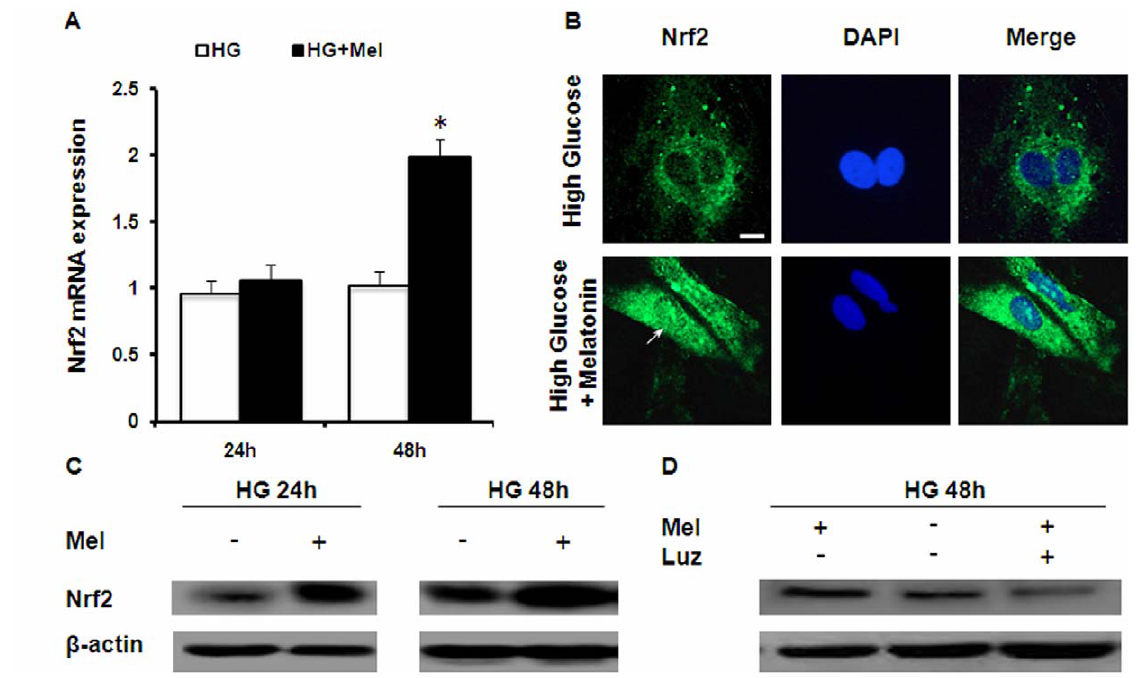
Figure 4. Effects of melatonin on Nrf2 expression and localization in Mu¨ller cells. (A) The mRNA level of Nrf2 was measured by real-time RT-PCR after 24 and 48 hr exposure to high glucose with or without melatonin. (B) Immunostaining of Nrf2 localization after high glucose and melatonin treatment. The nuclei were counterstained with DAPI. Scale bar=5 m m. (C) Western blot analyses of Nrf2 protein after 24 and 48 hr treatment. (D) Effects of luzindole on Nrf2. Data presented are representative of three independent experiments. (*P , 0.05).